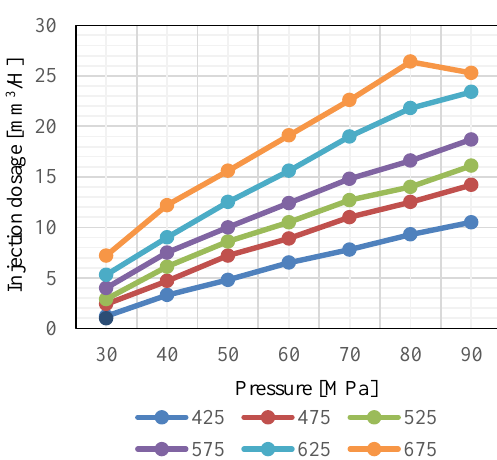
Fig. 3. Performance characteristics of the tested fuel injector – parameters measured on the test bench